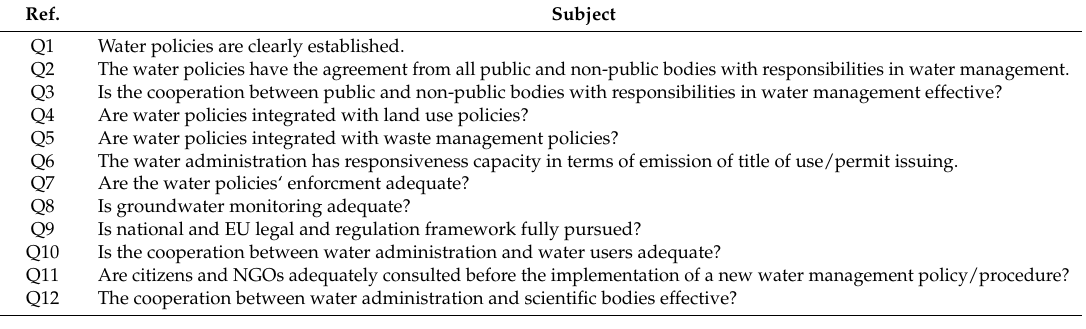
Table 2. Questions related to groundwater management in the Azores in the stakeholder survey. Ref.